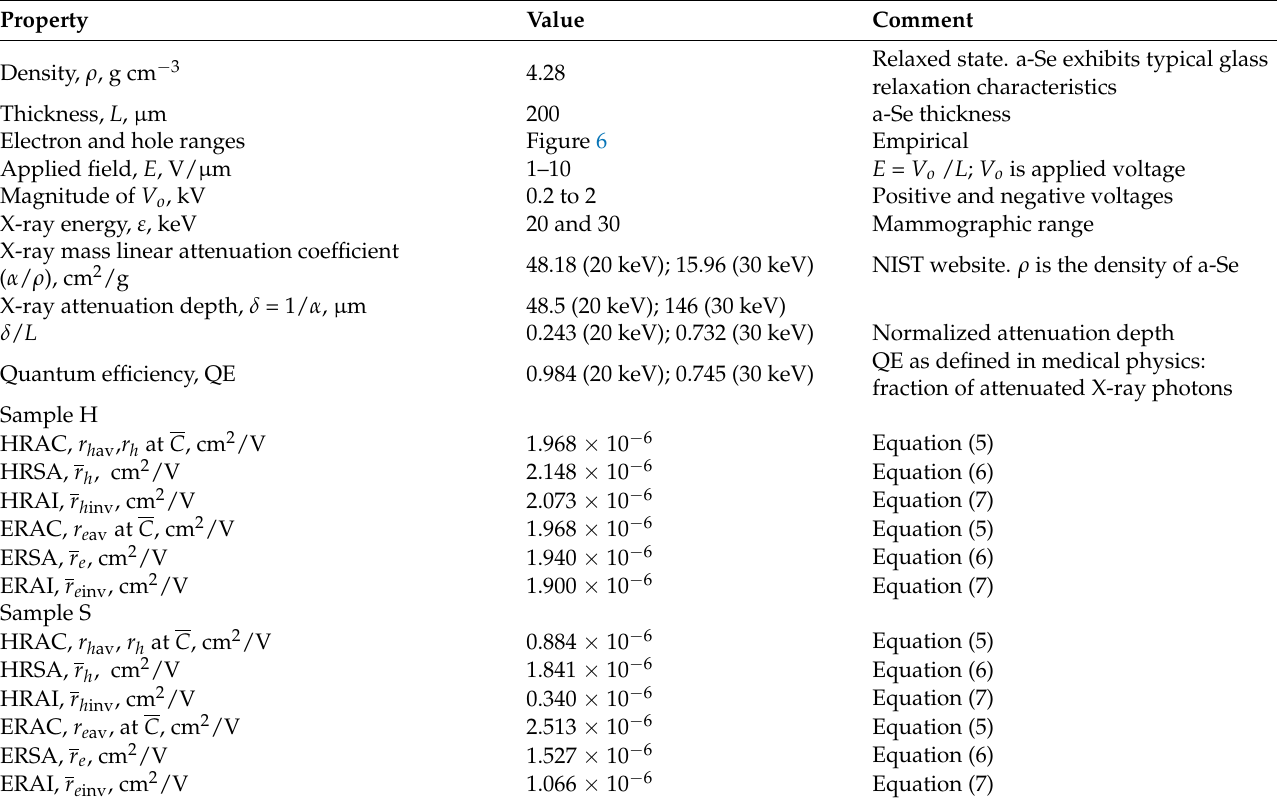
Table 2. Values for various quantities in the CE